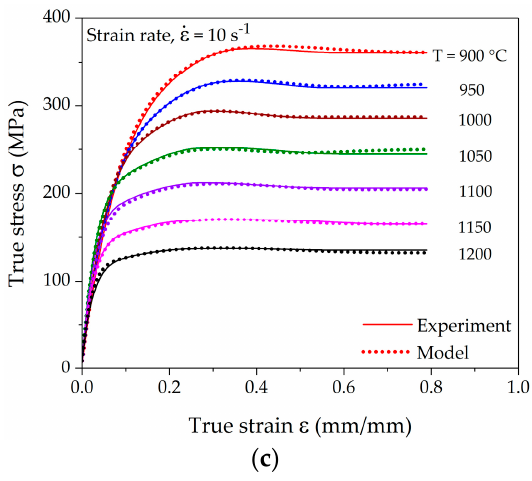
Figure 8. Fit of the computed flow curves with measured data from hot compression tests at different temperatures and strain rates of ( a ) 0.1 s − 1 ; ( b ) 1 s − 1 ; and ( c ) 10 s − 1 .